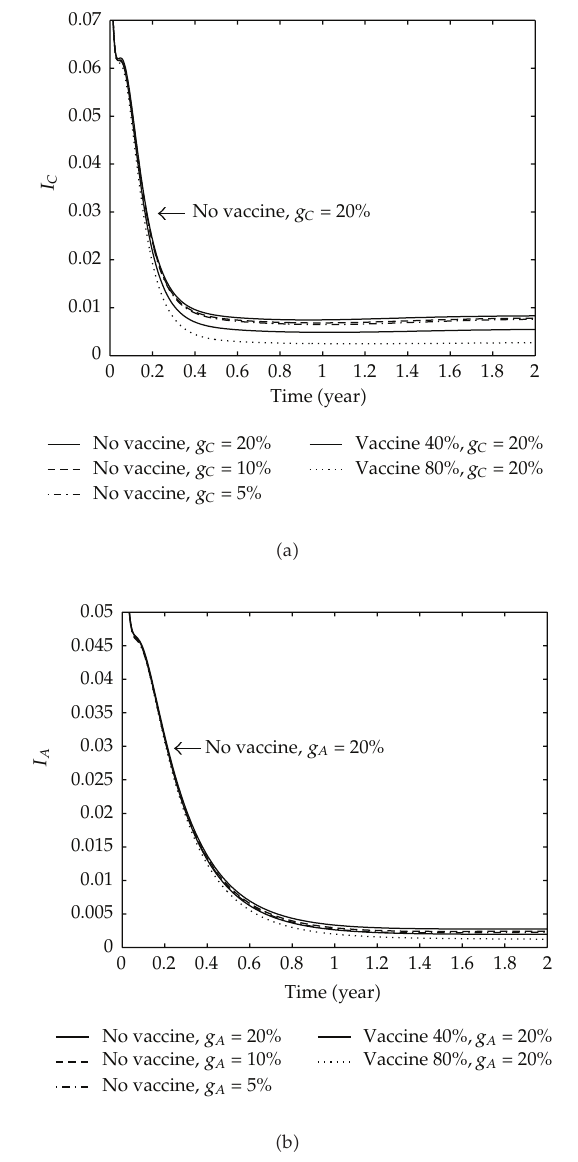
Figure 9: Dynamics of some scenarios. Here, we take (cid:5) 0.3, 0.1, 0.5, 0.1, 0.1, 0.1 (cid:6) as the initial